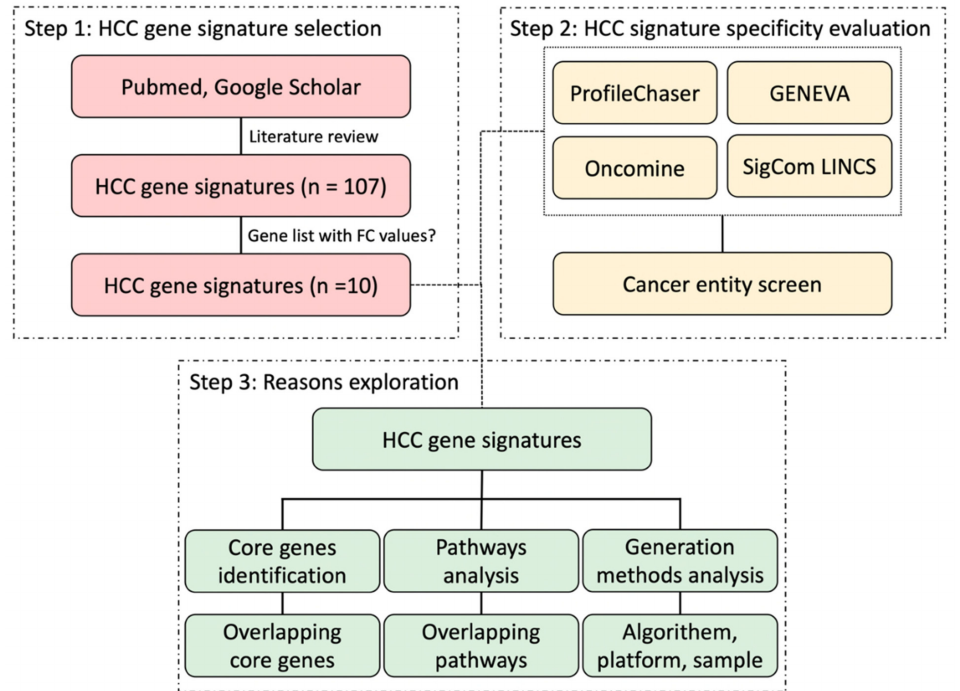
Figure 1. Workflow of this study. FC: fold